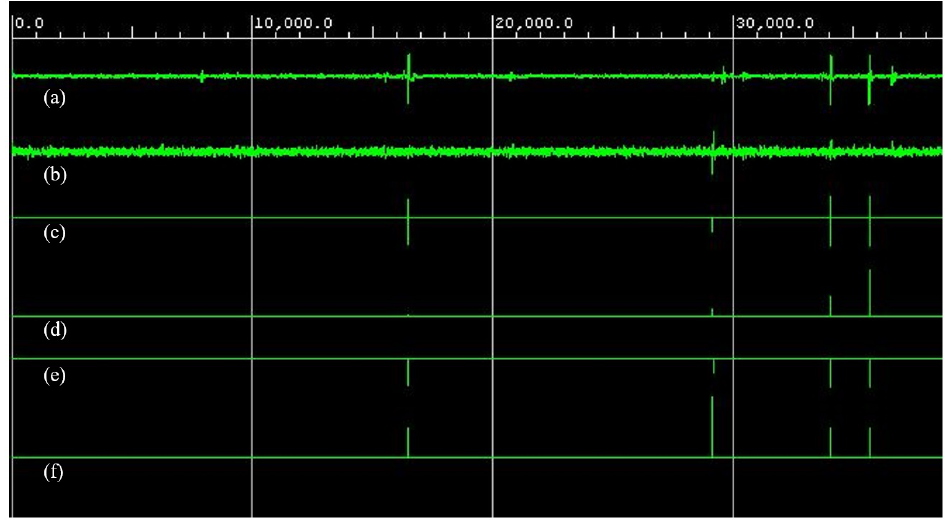
Figure 11. Waveforms from the multichannel (two-channel) filtered input system: ( a ) input signal from Channel-1 (Ch_In_1), ( b ) input signal from Channel-2 (Ch_In_2), ( c ) output wave during neural activity (Op_Wave), ( d ) timestamp (Op_Time), ( e ) peak amplitude (Op_Amp) and ( f ) channel identification